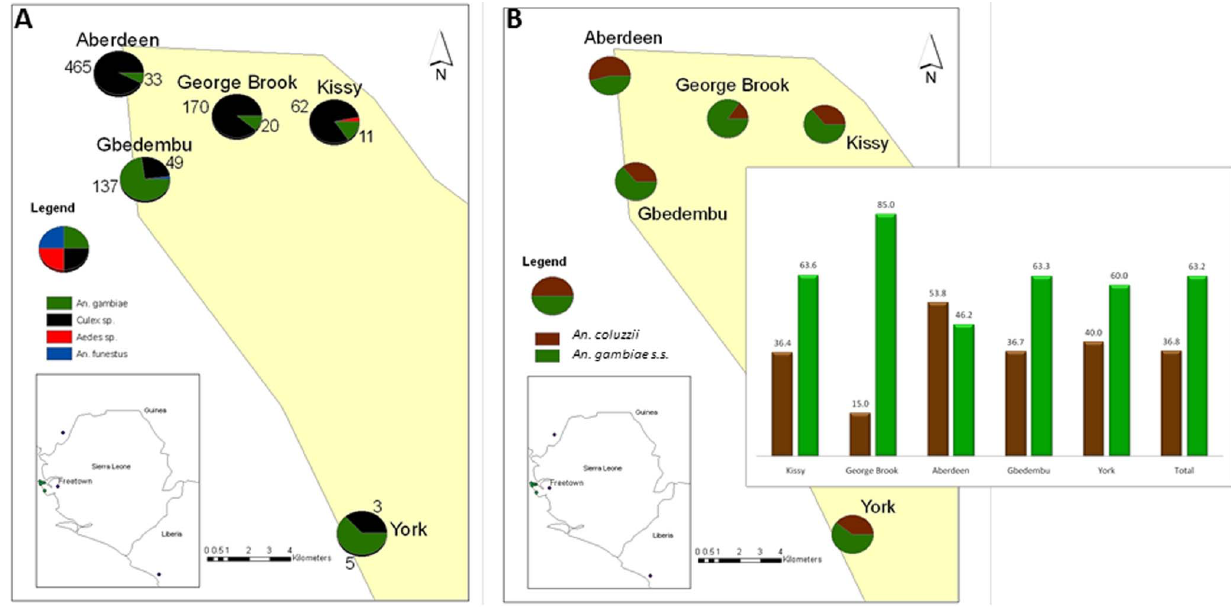
Figure 1. Distribution of the mosquito species, the An.coluzzii and the An.gambiae s.s from the sample communities in Freetown, Sierra Leone.